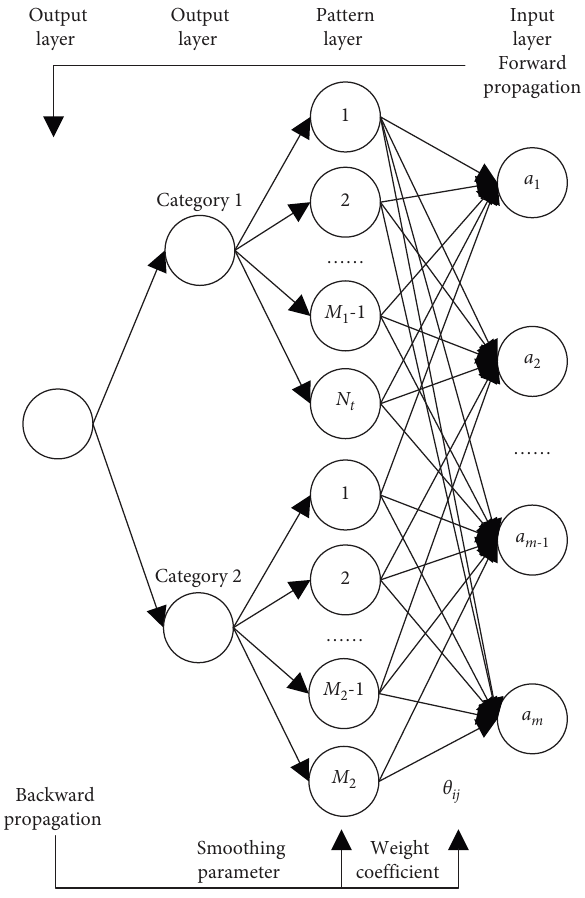
Figure 4: Structure of the constructed